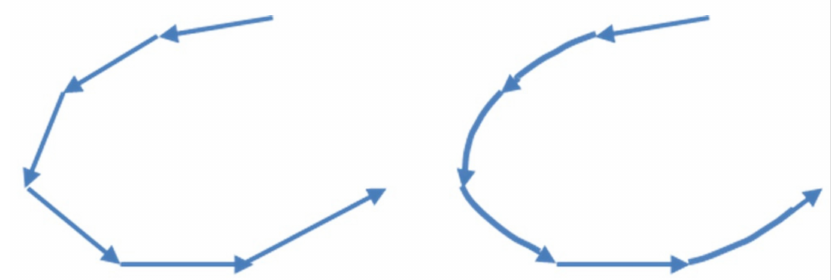
Figure 10. Schematic diagram of trajectory comparison before ( left hand side) and after ( right hand side) Hermite difference polynomial trajectory optimization.